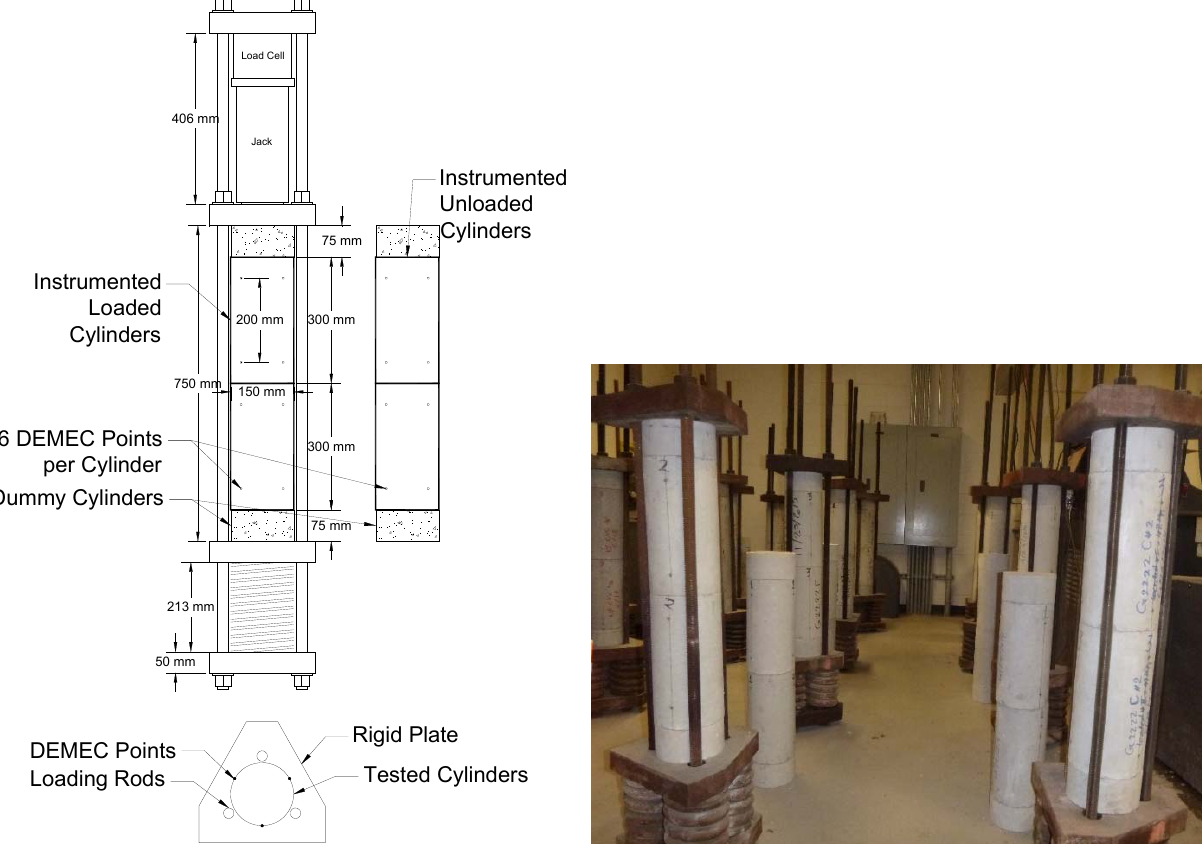
Figure 3. Creep test setup and specimen dimensions (25 mm = 1 in.).